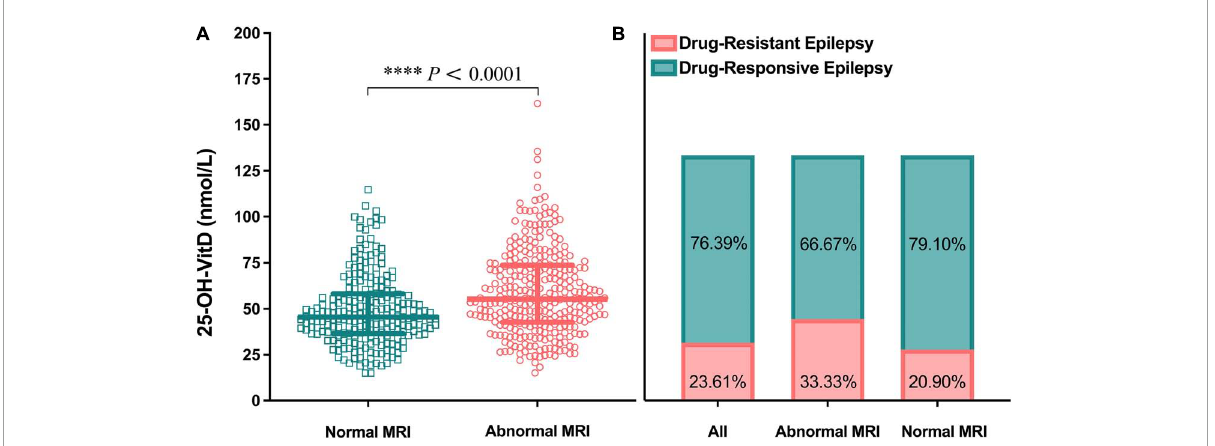
FIGURE9 Comparison in serum 25-OH-VitD status of children with epilepsy of different brain magnetic resonance imaging (MRI) findings. (A) Comparison in serum 25-OH-VitD status between abnormal and normal brain MRI findings group. (B) Proportion of children with drug-resistant epilepsy and drug-responsive epilepsy of all pediatric patients with epilepsy, patients with abnormal brain MRI findings and patients with normal brain MRI findings.